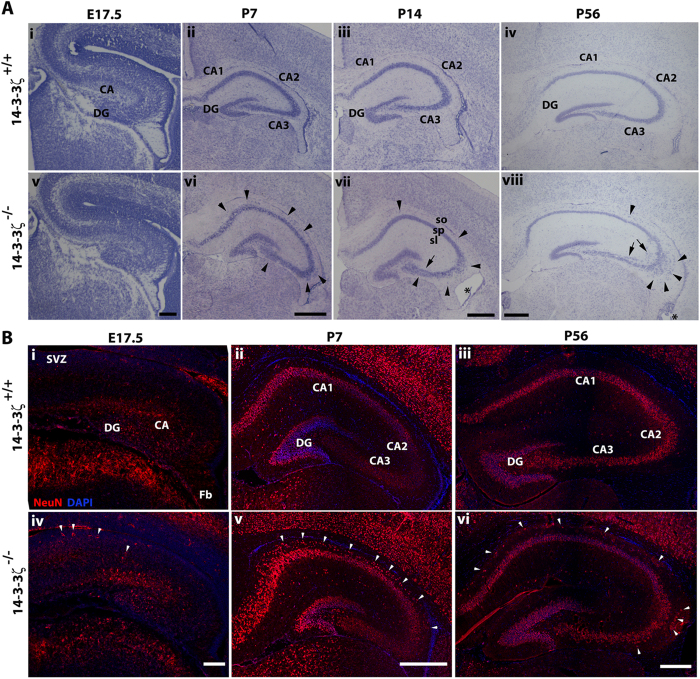
Hippocampal lamination defects in 14-3-3ζ-deficient mice.(A) Nissl staining shows the hippocampal development of 14-3-3ζ+/+ (i–iv) and 14-3-3ζ−/− (v–viii) mice from embryonic day (E) 17.5 until post natal day (P) 56. During embryonic development no gross structural defects could be seen in 14-3-3ζ−/− mice (i and v). Pyramidal neurons in the cornu ammonis (CA) subfields, CA1-3, were dispersed in the stratum pyramidale (sp) and stratum oriens (arrowheads) layer in 14-3-3ζ−/− mice. Arrows highlight the duplicated layer of hippocampal pyramidal neurons in stratum radiatum (sr). Scale bar = 100 μm. (B) Coronal sections of the hippocampus obtained from E17.5 (i and iv), P7 (ii and v) and P56 (iii and vi) 14-3-3ζ+/+ and14-3-3ζ−/− mice. At E17.5 the stratum pyramidale is populated by NeuN-positive pyramidal cells in 14-3-3ζ+/+ hippocampi forming a uniform mature zone in the developing CA. In 14-3-3ζ−/− hippocampi, the maturation zone was less uniform with some NeuN-positive mature pyramidal cells ectopically positioned in the superficial zone of the stratum pyramidale in the CA and others in the sub ventricular zone (SVZ; white arrowheads). In P7 and P56 14-3-3-ζ−/− mice, NeuN immunostaining identifies mature pyramidal neurons ectopically positioned in the stratum oriens of CA1-3 (arrowheads). Scale bars: 100 μm.